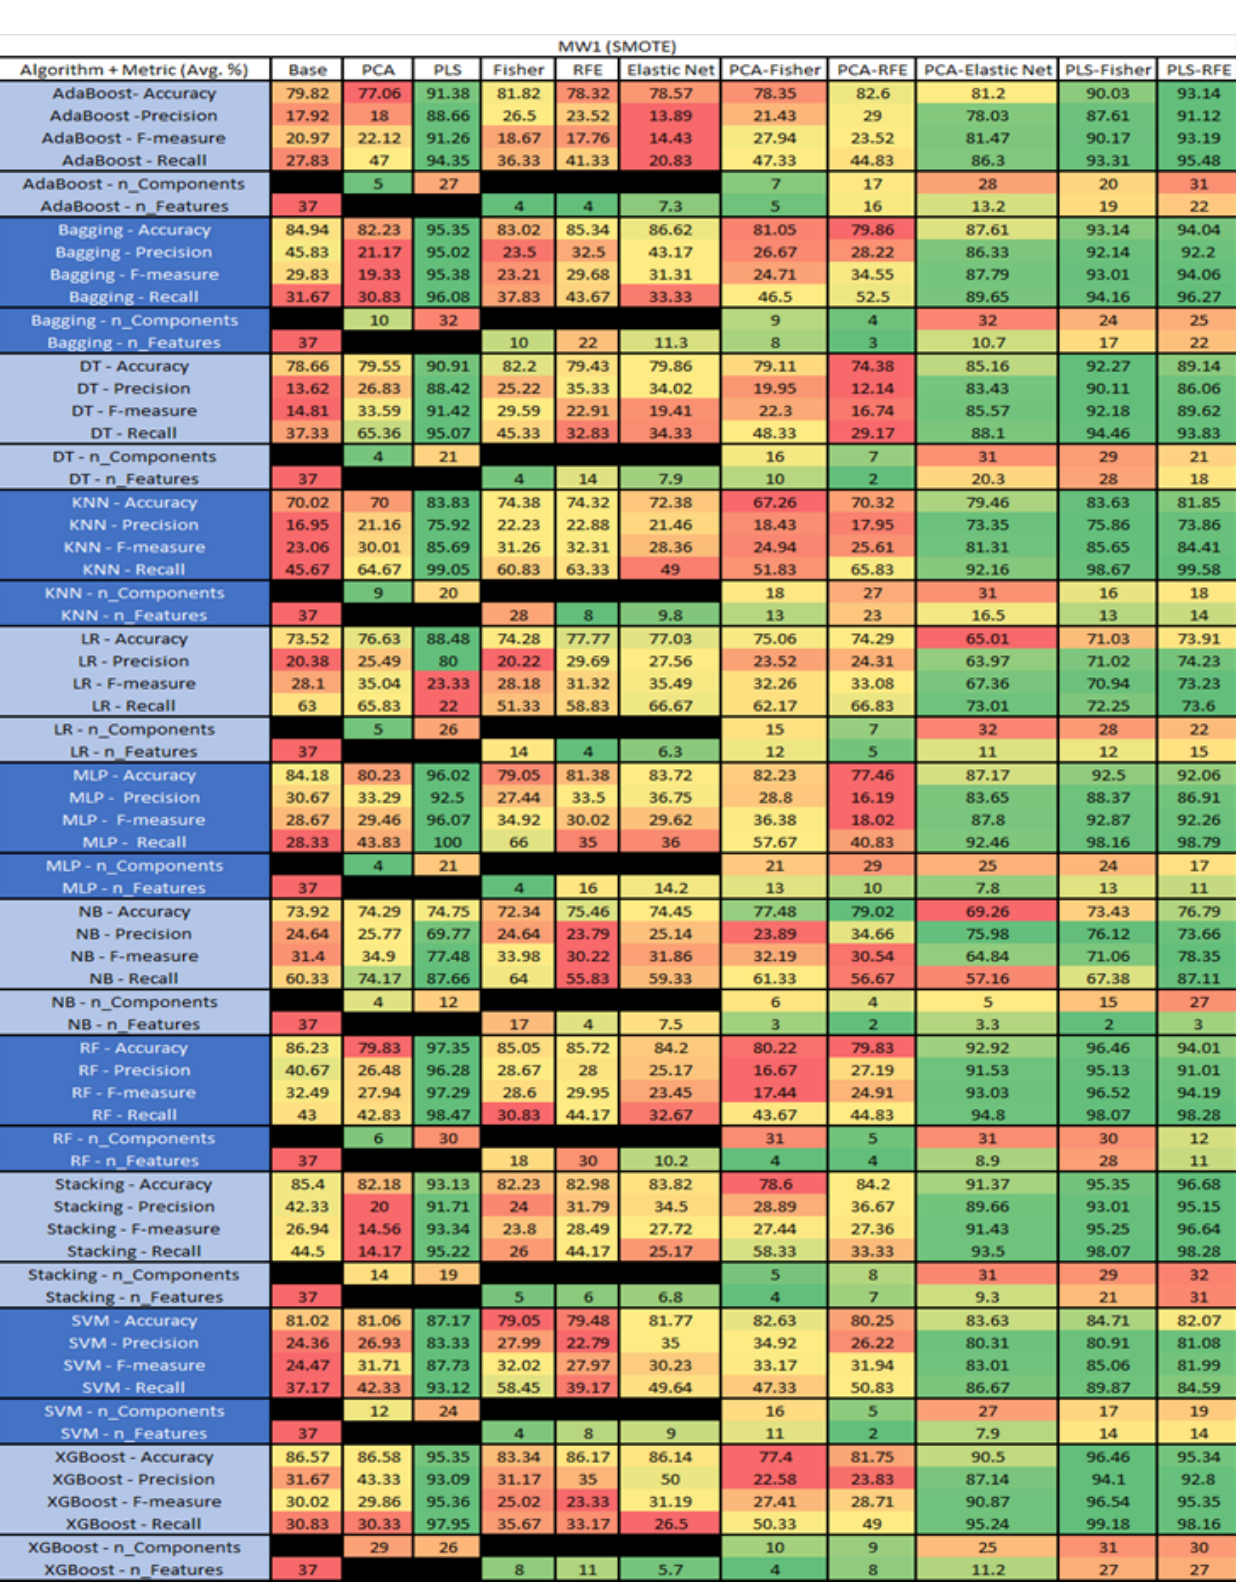
Figure 39. MW1 SMOTE NASA MDP Results Data